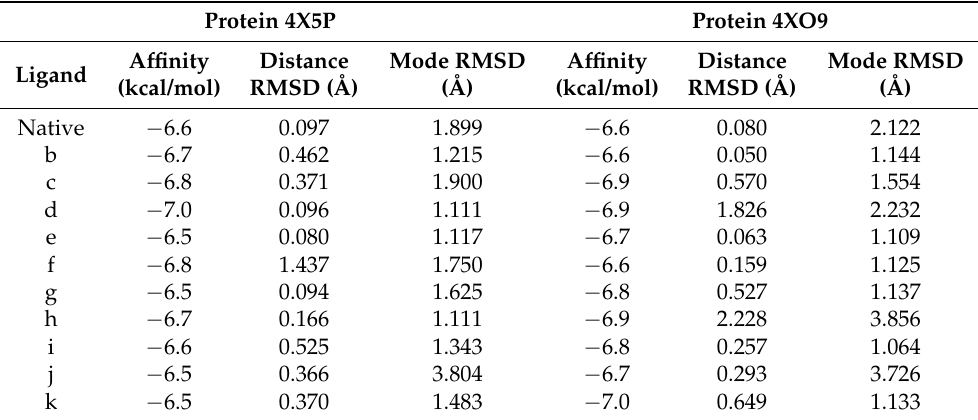
Table 4. Calculated affinities and RMSDs for the most stable conformation of each binder within each